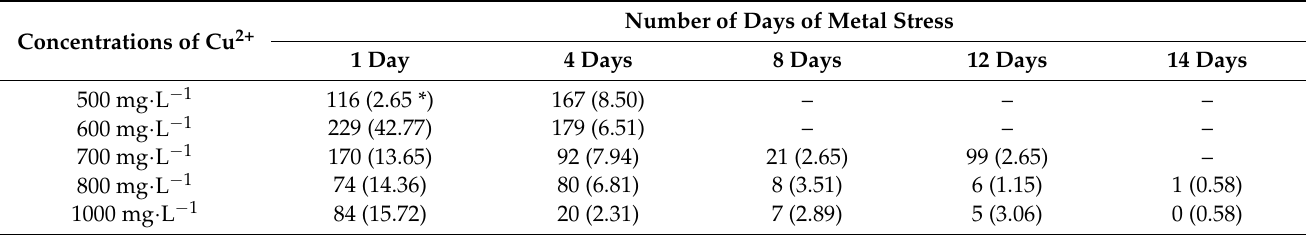
Figure 3. Digital photos of the growth status of the domesticated Y. lipolytica . Table 2. The number of Yarrowia lipolytica colonies domesticated by different Cu 2+ concentrations grew on the YM solid medium (obtained by counting).